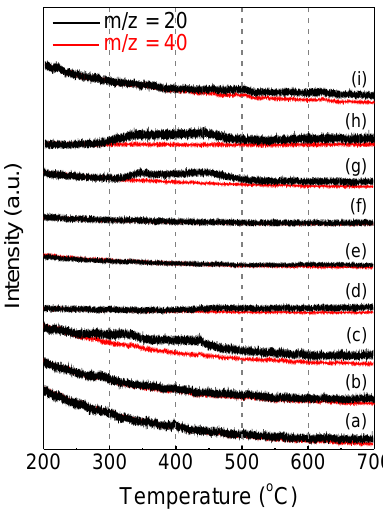
Figure 2. MS spectra of 5 mg ( a ) commercial FeOF powder; ( b ) acetylene black-mixed FeOF powder; ( c ) fresh FeOF cathode, discharged FeOF cathodes down to ( d ) 2.0; ( e ) 1.3; and ( f ) 0.7 V, and charged FeOF cathodes up to 4.0 V after discharge down to ( g ) 2.0 V; ( h ) 1.3 V; and ( i ) 0.7 V, respectively.